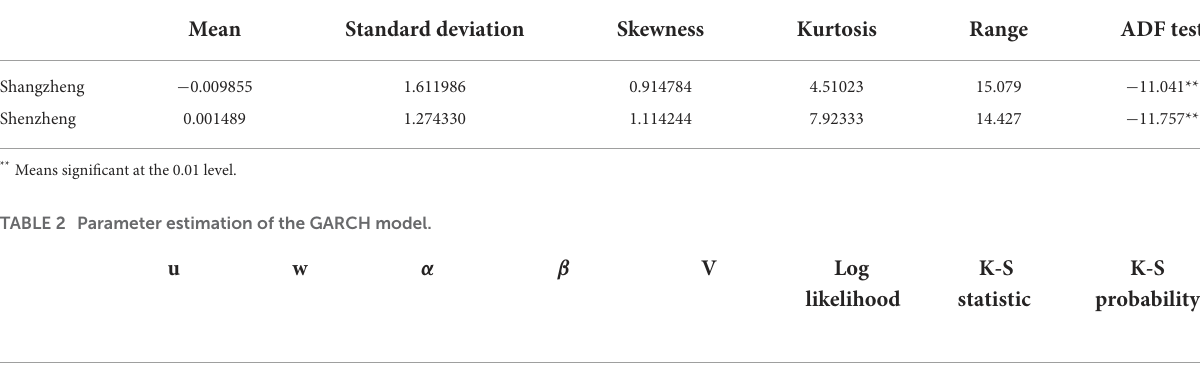
TABLE 1 Analysis of statistical characteristics of the return rate.